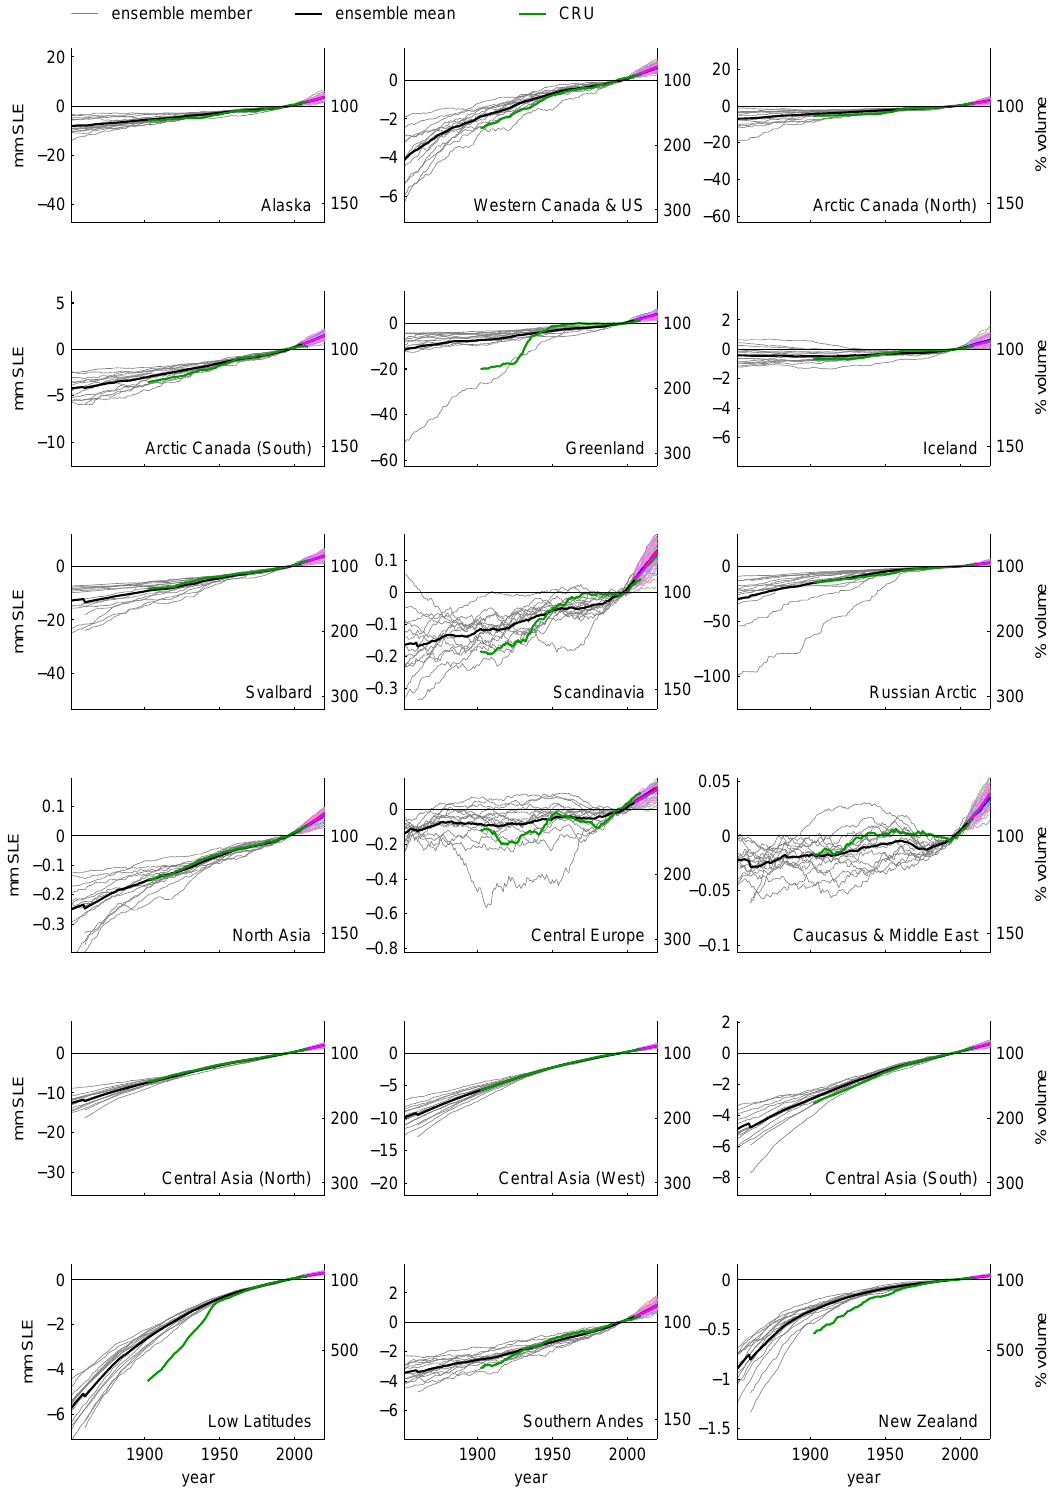
Fig. 19. Cumulative regional surface mass balances relative to the 1986–2005 mean from the model forced with historical CMIP5 simulations. Gray lines: model forced by individual CMIP5 ensemble members, black line: mean of gray lines, green line: results from CRU-forced model. Colors after the year 2005 indicate RCP scenarios, see Fig.